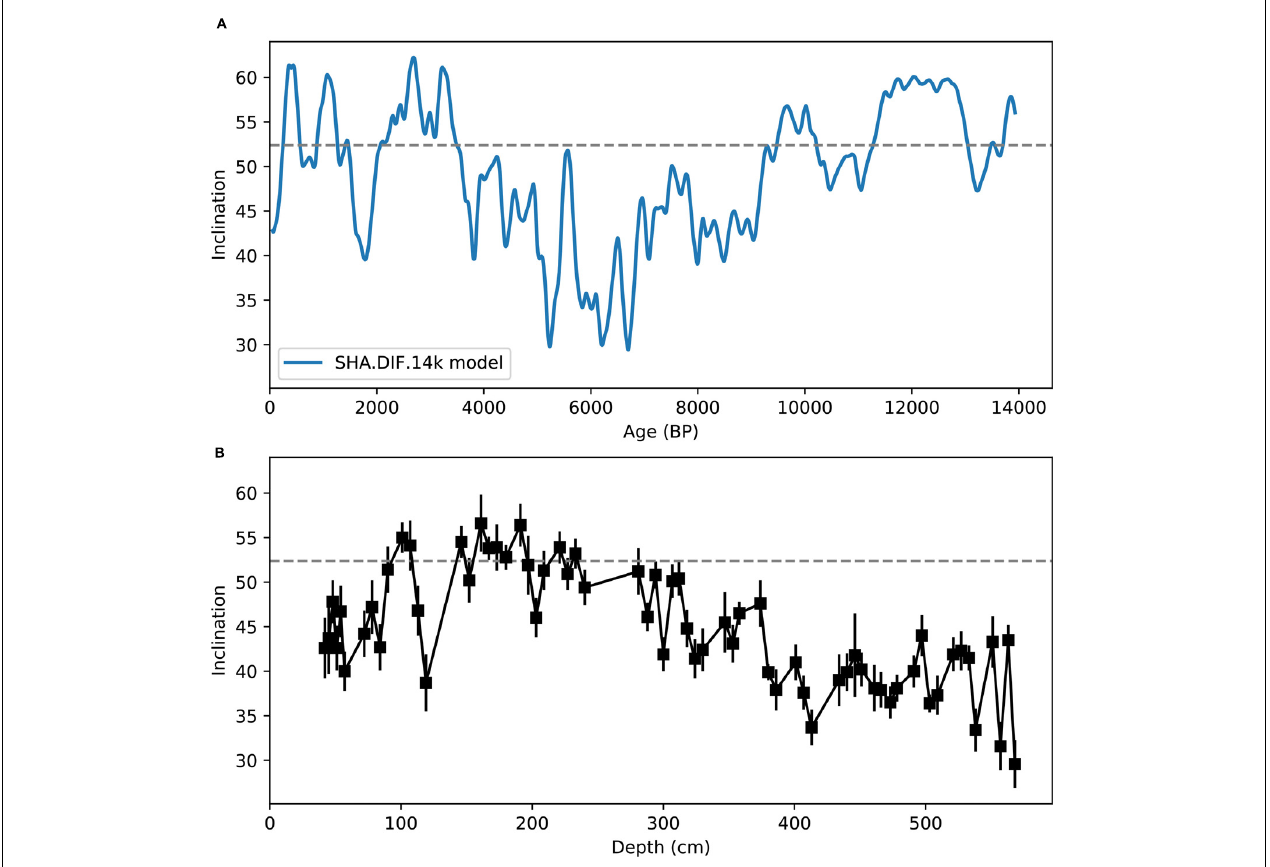
FIGURE 5 | Paleomagnetic inclination. (A) Geomagnetic inclination predicted by SHA.DIF.14k model (Pavón-carrasco et al., 2014) at the sampling site. (B) Depth profile of paleomagnetic inclinations in